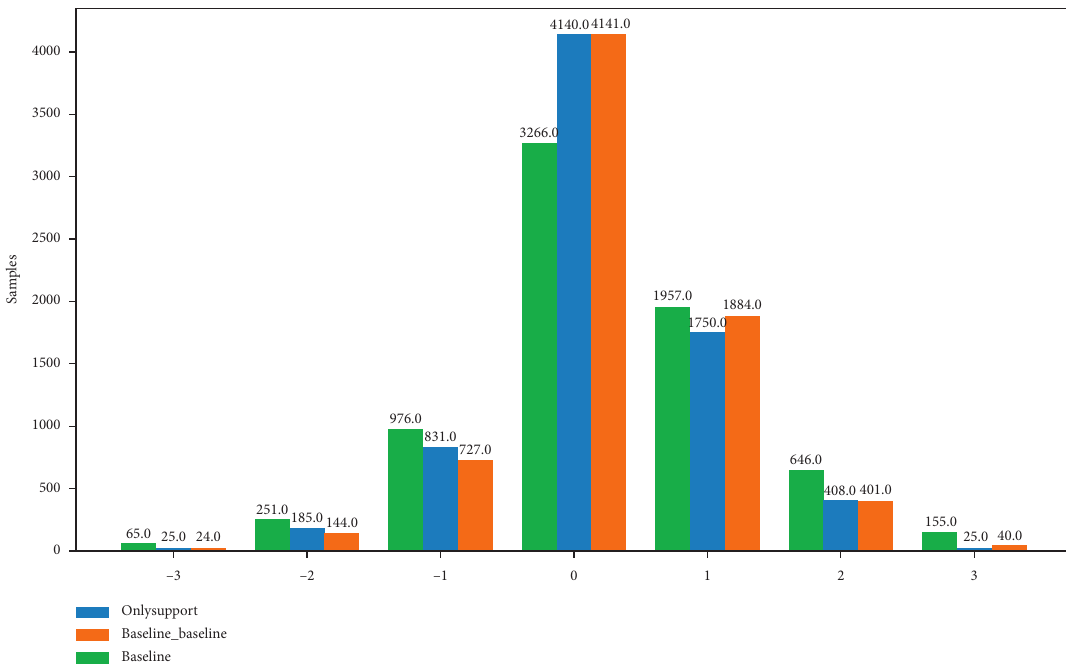
Figure 8: Number of predictions minus number of gold